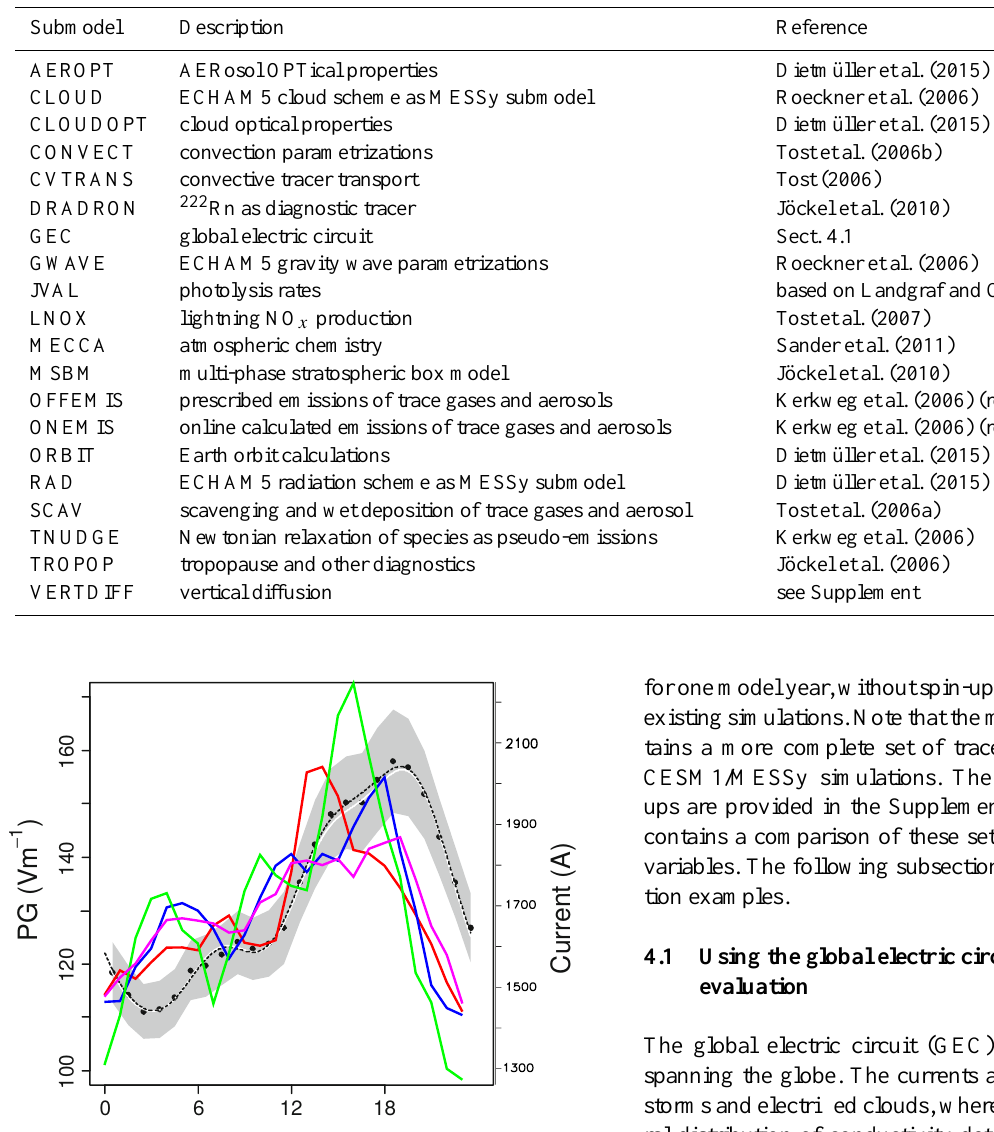
Table 1. List of process and diagnostic submodels used in the simulations presented here. For a full list of available submodels, see Table 1 in Jöckel et al. (2010) or the MESSy website (http://www.messy-interface.org/).